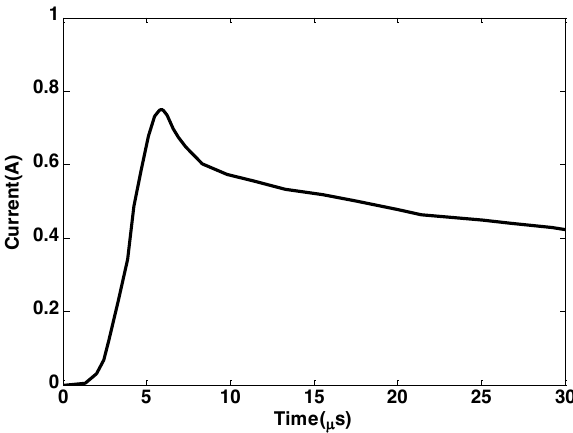
Figure 8: Frequency variation of electrical parameters of soil for low-frequency resistivity .